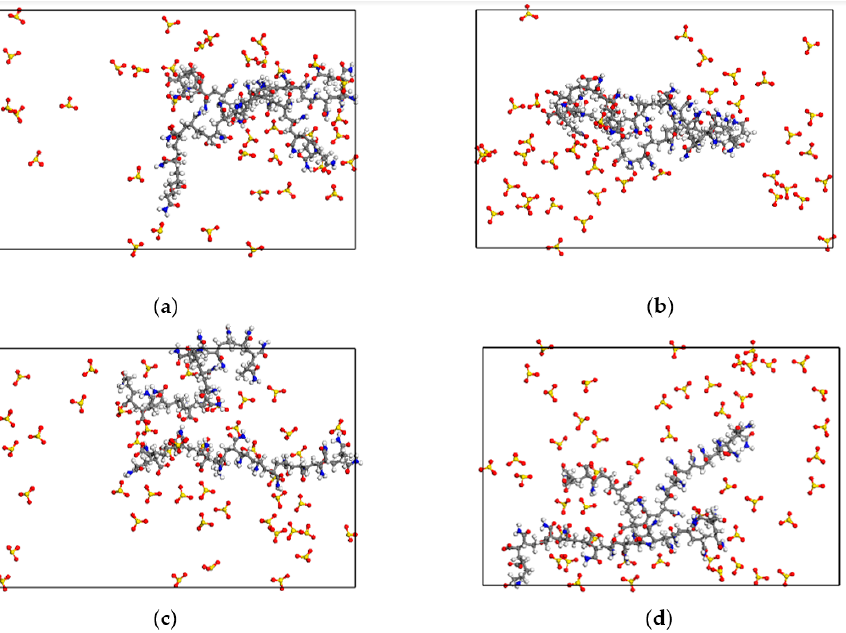
Figure 18. Sectional snapshots of the gas–liquid interface in foam systems with different SDBS con- centrations after dynamic relaxation equilibrium. ( a ) 1.25 µmol/m² system; ( b ) 1.39 µmol/m² system; ( c ) 1.53 µmol/m² system; ( d ) 1.67 µmol/m² system. system; ( c ) 1.53 µ mol/m 2 system; ( d ) 1.67 µ mol/m 2